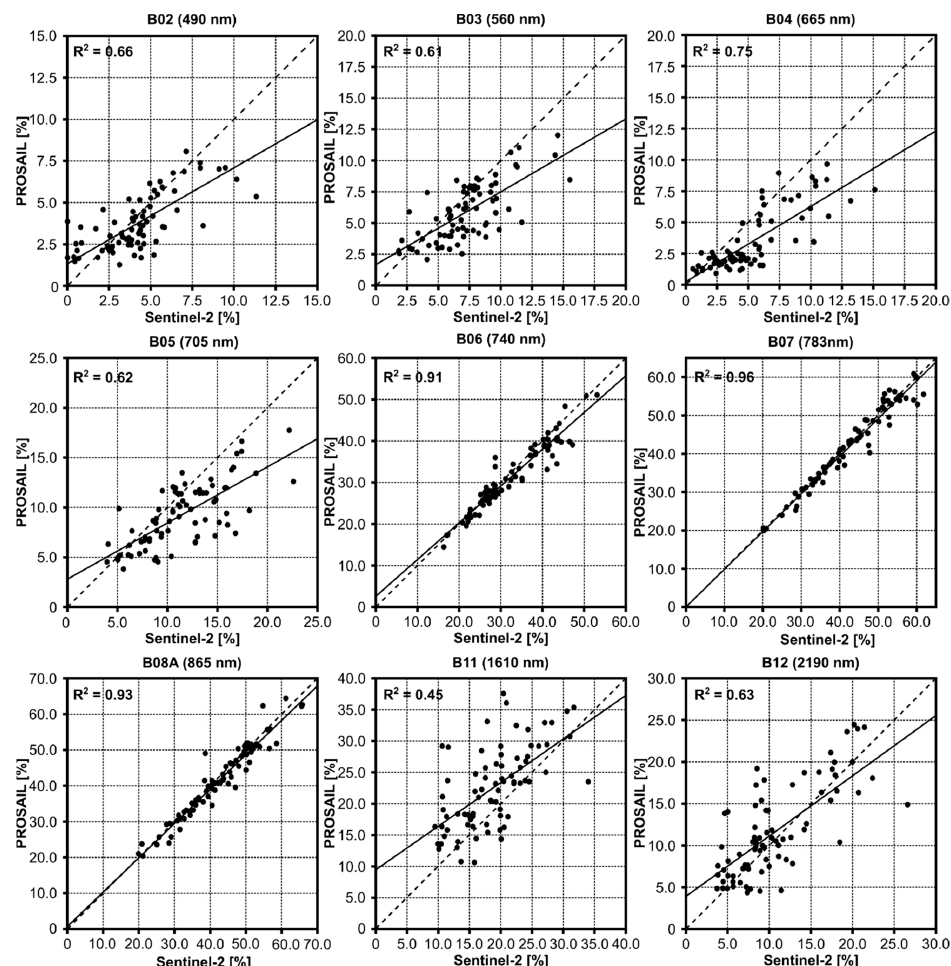
Figure 9. Scatter plots over Sentinel-2 spectral bands between Sentinel-2 observations and PROSAIL simulations calculated for in situ sample points with known biophysical parameters.